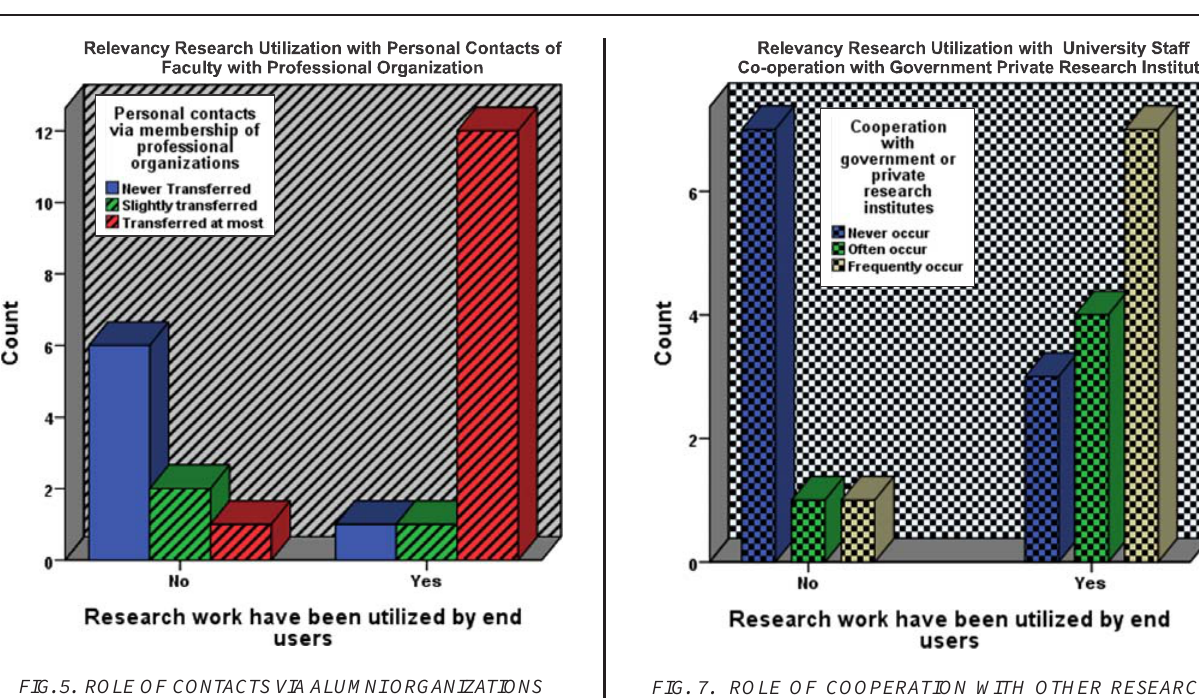
FIG. 7. ROLE OF COOPERATION WITH OTHER RESEARCH INSTITUTES TOWARDS UTILIZATION OF KNOWLEDGE CAPITAL